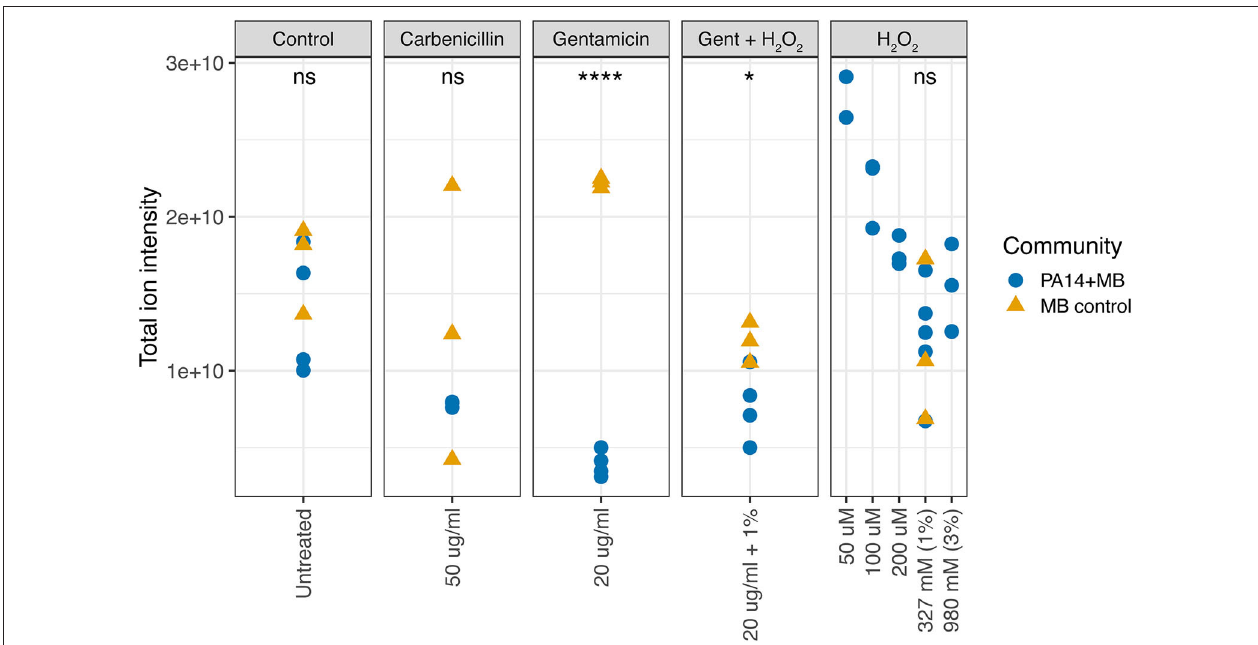
FIGURE 4 | Total ion intensity of all volatile compounds. The PA14 + MB community represents the microbial community on a meat sample with both PA14 and MB(PA14) populations. The MB control community is a meat sample with only the meat microbial background. Significant differences were found for gentamicin ( p = 2.2 × 10 − 6 , T -test) and gentamicin + H 2 O 2 ( p = 0.034, T